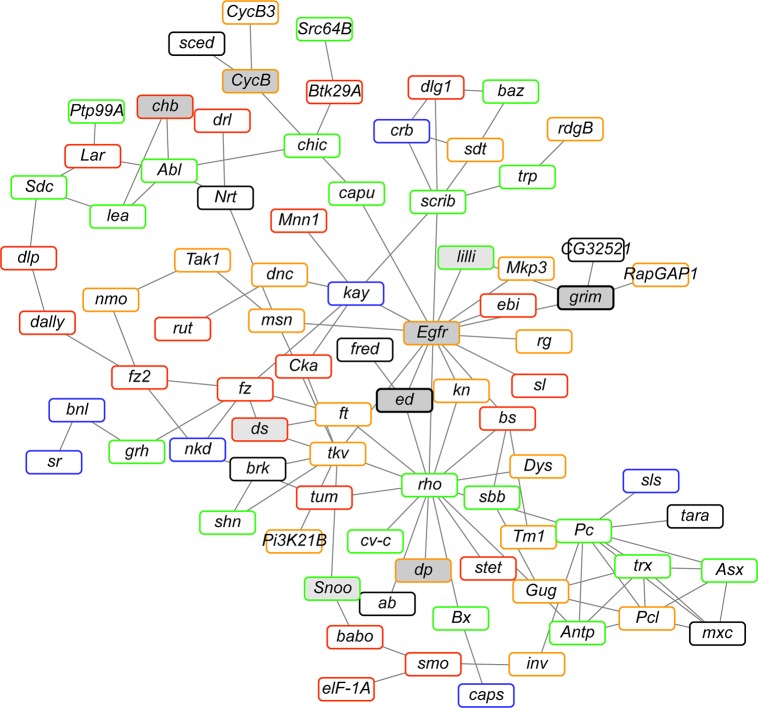
Significant genetic interaction network of genes identified in the GWA analyses for all cocaine and methamphetamine related traits combined.Borders indicate the strength of the evidence for a human ortholog. Black: DIOPT score < 3; Blue: DIOPT score 3–6; Green: DIOPT score 7–9; Orange: DIOPT score 10–12; Red: DIOPT score 13–15. See S7 Table for the complete list of human orthologs and their DIOPT scores. Grey boxes have effects on at least one drug-seeking behavior from RNAi knockdown of gene expression.